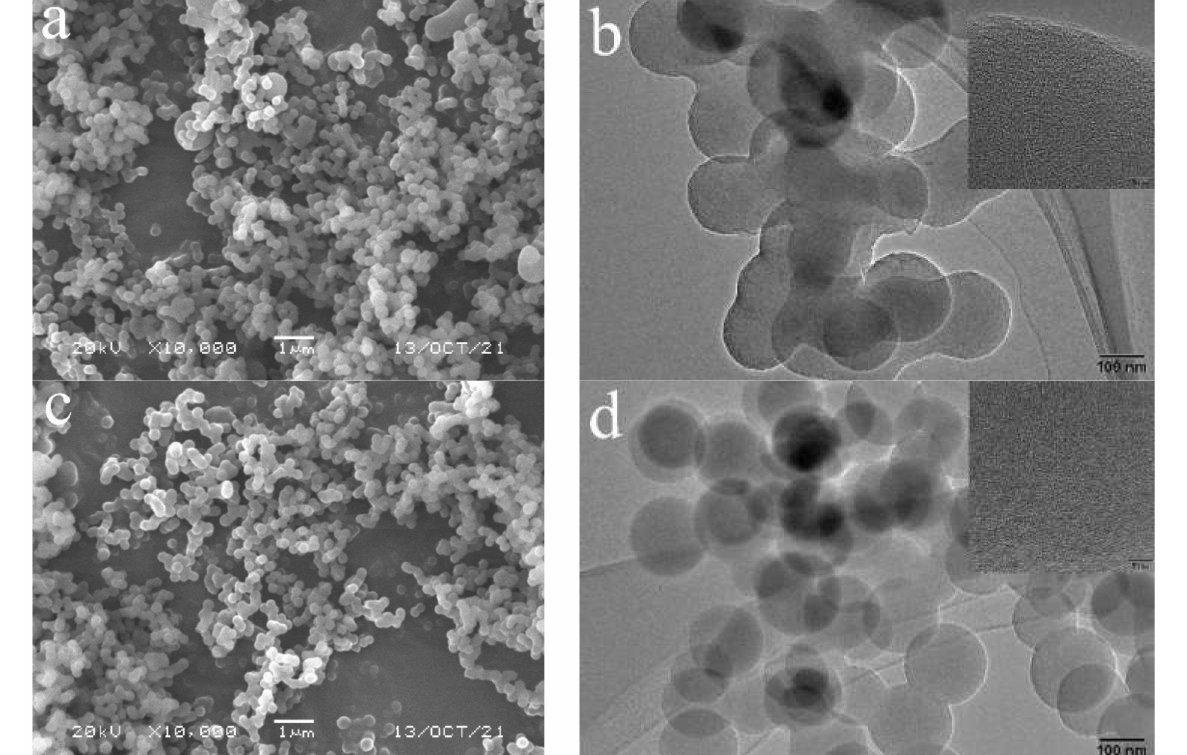
Figure 1. SEM ( a , c ) and HRTEM ( b , d ) images of carbon spheres ( a , b ) and carbon-supported metal nickel ( c , d ).